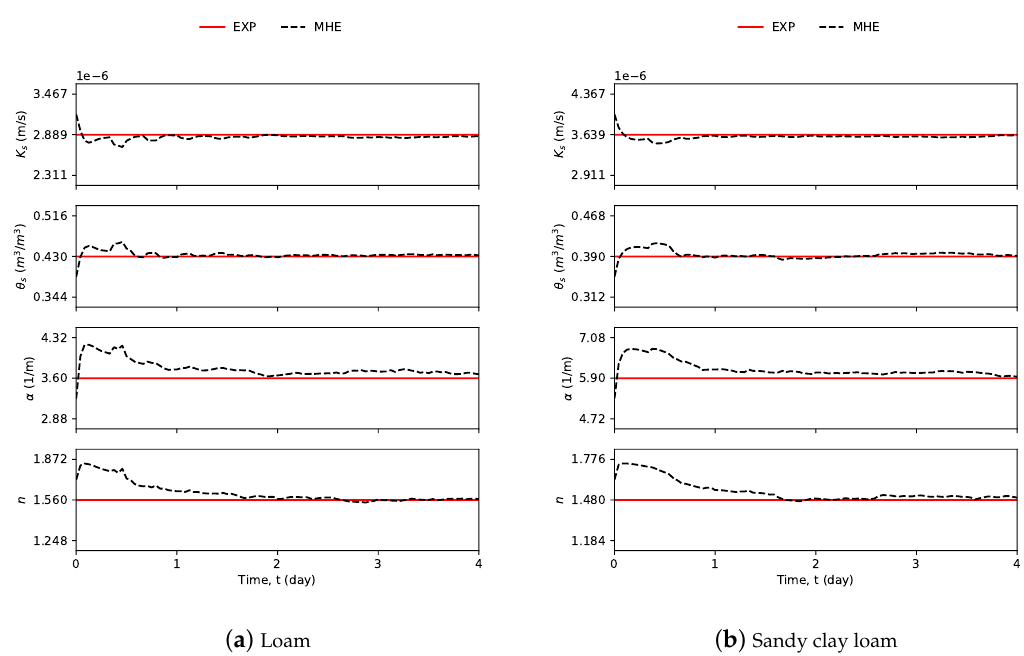
Figure 6. Trajectories of estimated parameters using DeMHE, compared with their actual